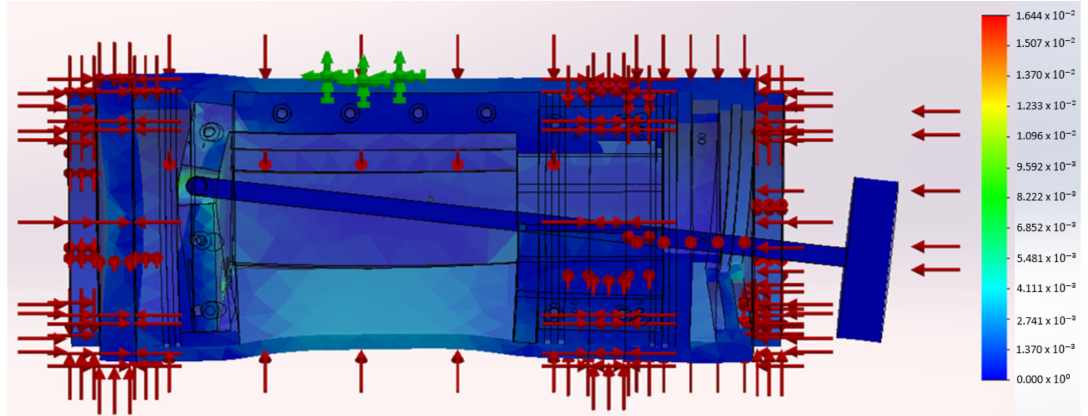
Figure 10. FEM simulation strain results of the sea pressure on the BCM